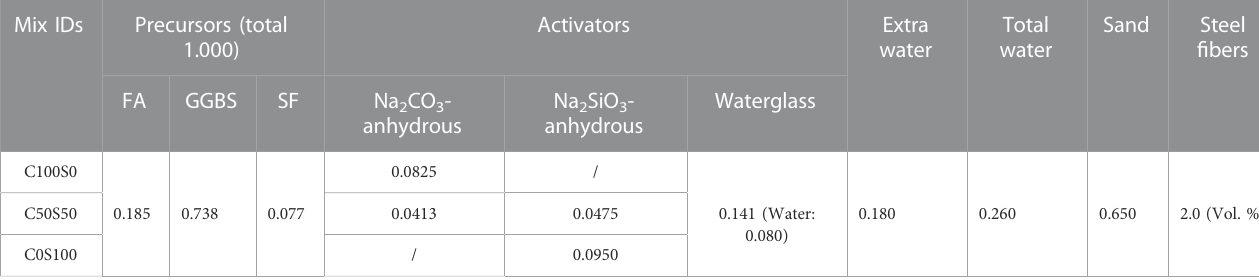
TABLE 1 Mix proportions of SH-UHPGC (weight